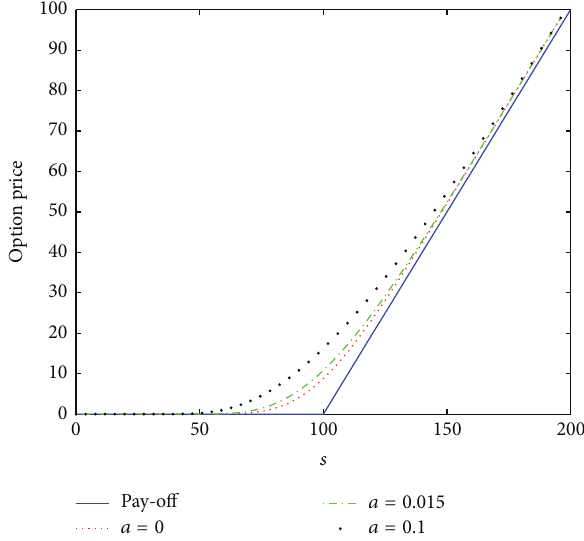
Figure2:OptionpricingofavanillaEuropeancalloptionforseveral values of parameter 𝑎 at maturity time 𝑇 = 1 year, where ℎ = 4 and Δ𝑡 = 0.002 .